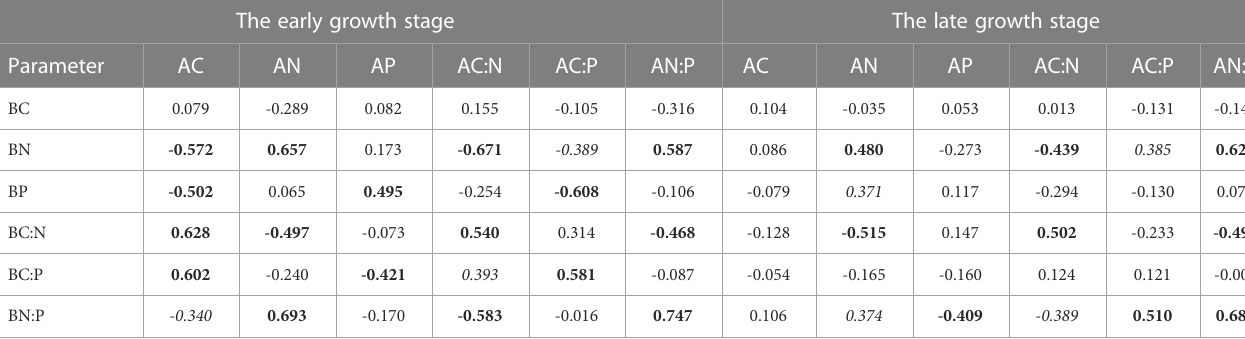
TABLE 1 Relationships between the above- and below-ground parts C, N, P stoichiometries.